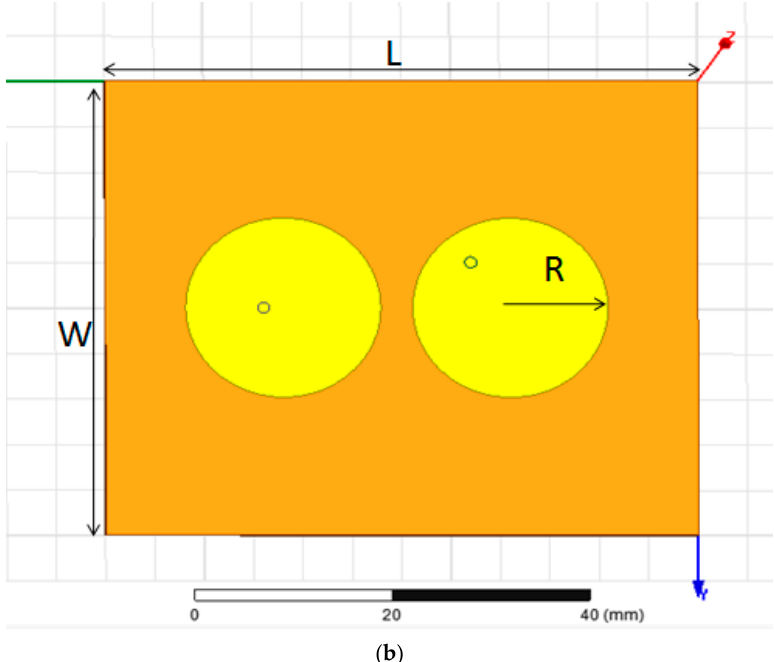
Figure 2. ( a , b ) A front outlook of the designed antenna.